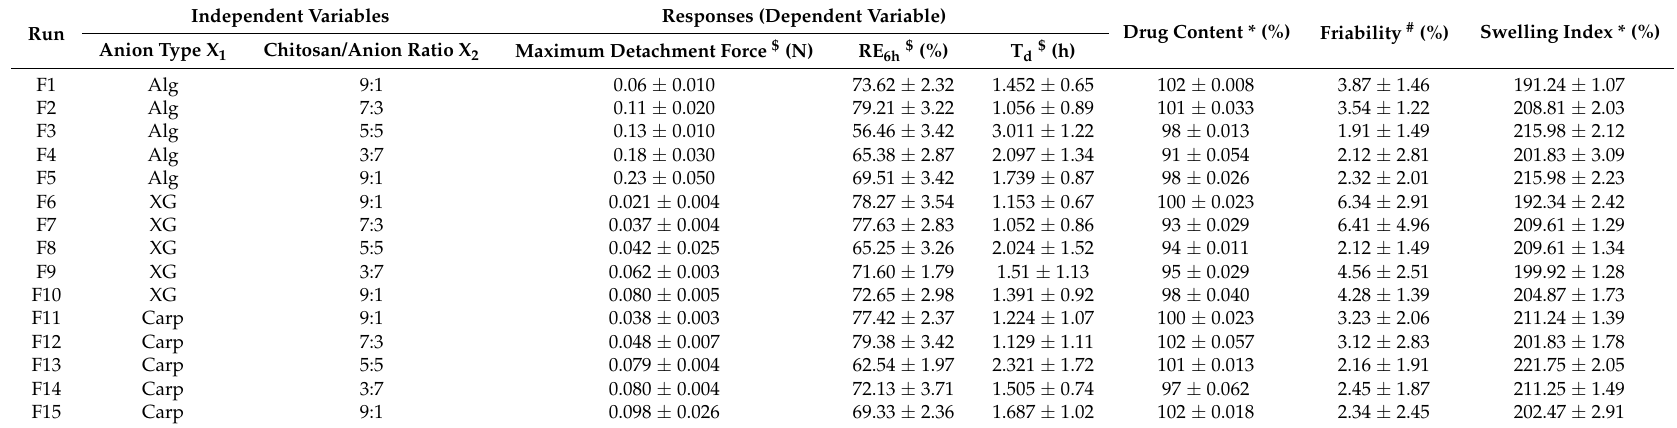
Table 1. Composition and characterization of fluconazole polyelectrolyte complex based vaginal inserts prepared according 3 1 5 1 full factorial